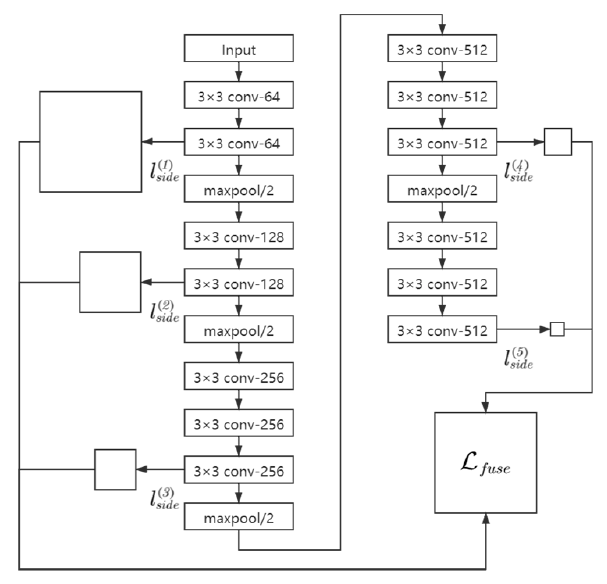
Figure 2. HED model output diagram.